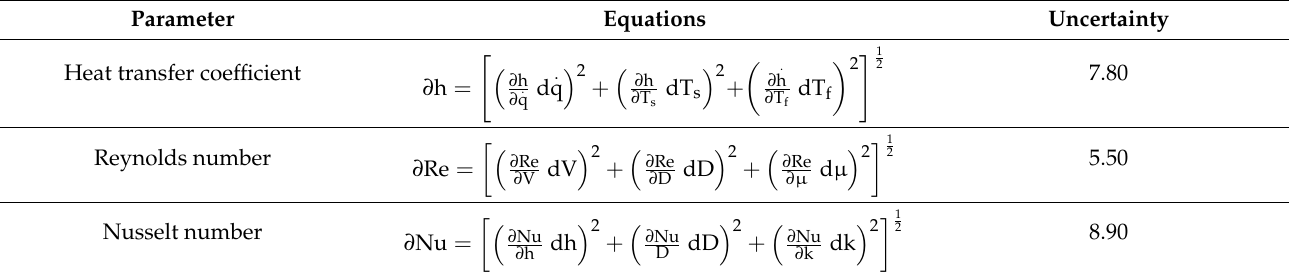
Table 4. Experiment uncertainty value and